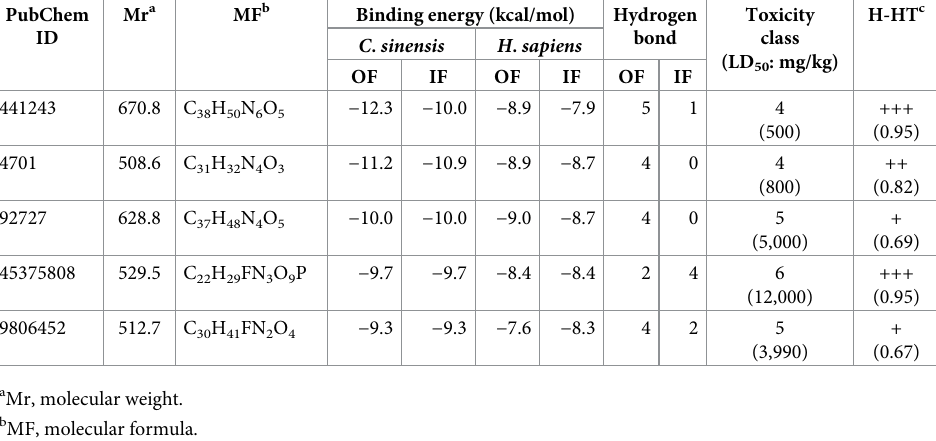
MF, molecular formula. c H-HT, human